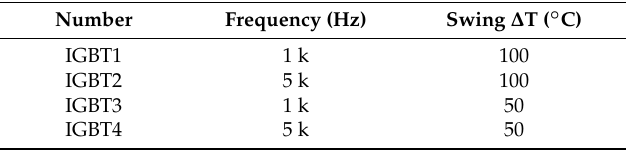
Figure 4. Experimental data. ( a ) IGBT1 expermental raw data; ( b ) IGBT2 expermental raw data; ( c ) IGBT3 expermental raw data; ( d ) IGBT4 expermental raw data.